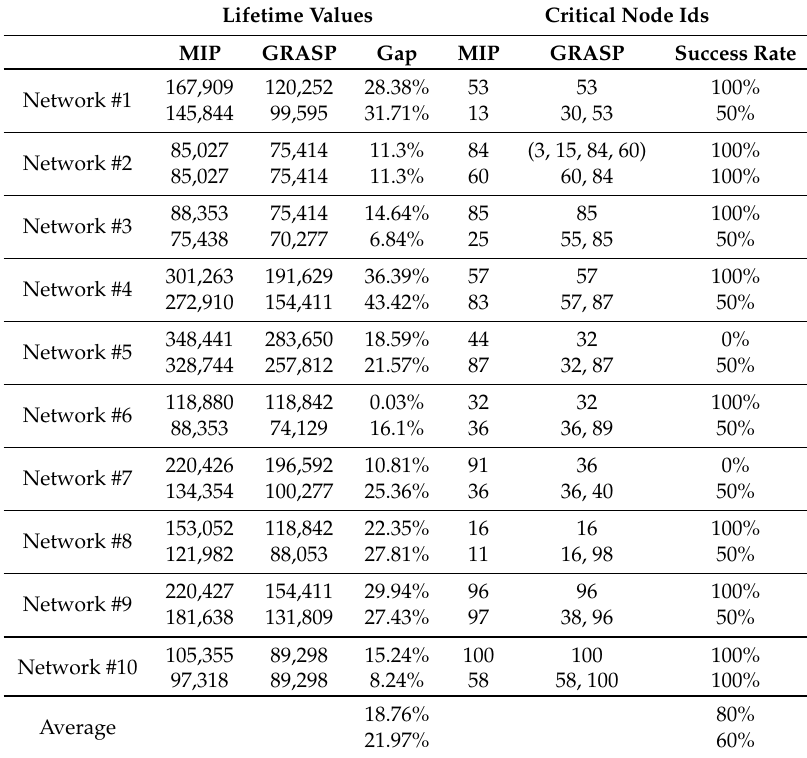
Table 9. Comparison between MIP and GRASP lifetime models. Nodes between parenthesis are interchangeable since they offer the same result when being